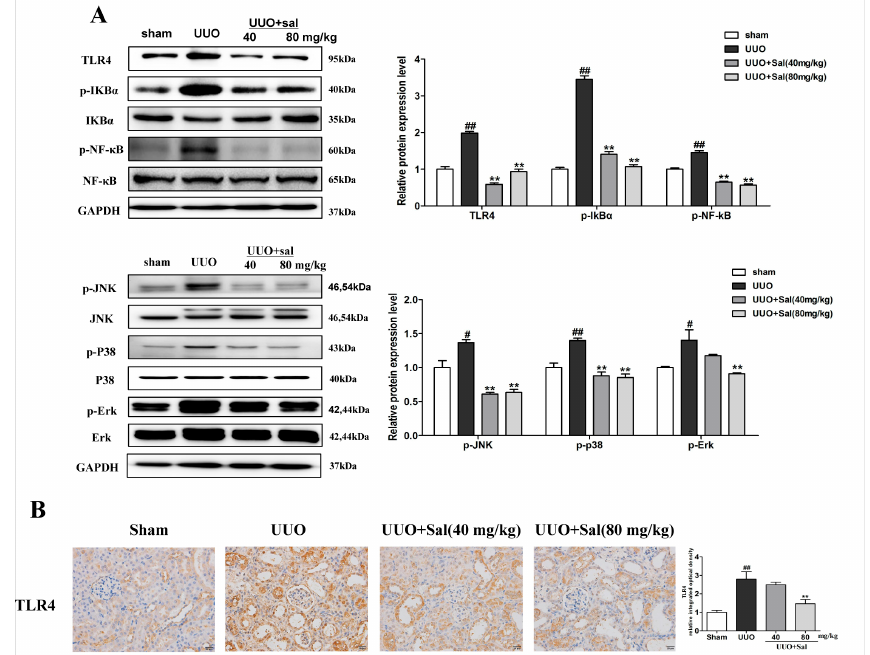
Figure 4. Sal suppresses renal inflammation via the TLR4/NF- κ B and MAPK signaling pathways in UUO mice. ( A ) Western blot analysis of TLR4, p-I κ B α , p-NF- κ B, p-P38, p-ERK, and p-JNK protein expression in the kidney tissue of UUO mice ( n = 3). ( B ) Immunochemical staining of TLR4 in the kidney tissue of UUO mice ( n = 3). Original magnification: × 200. All data are represented as mean ± SD. # P < 0.05, ## P < 0.01 vs. Sham group, * P < 0.05, ** P < 0.01 vs. UUO group. Int. J. Mol. Sci. 2019 , 20 , x